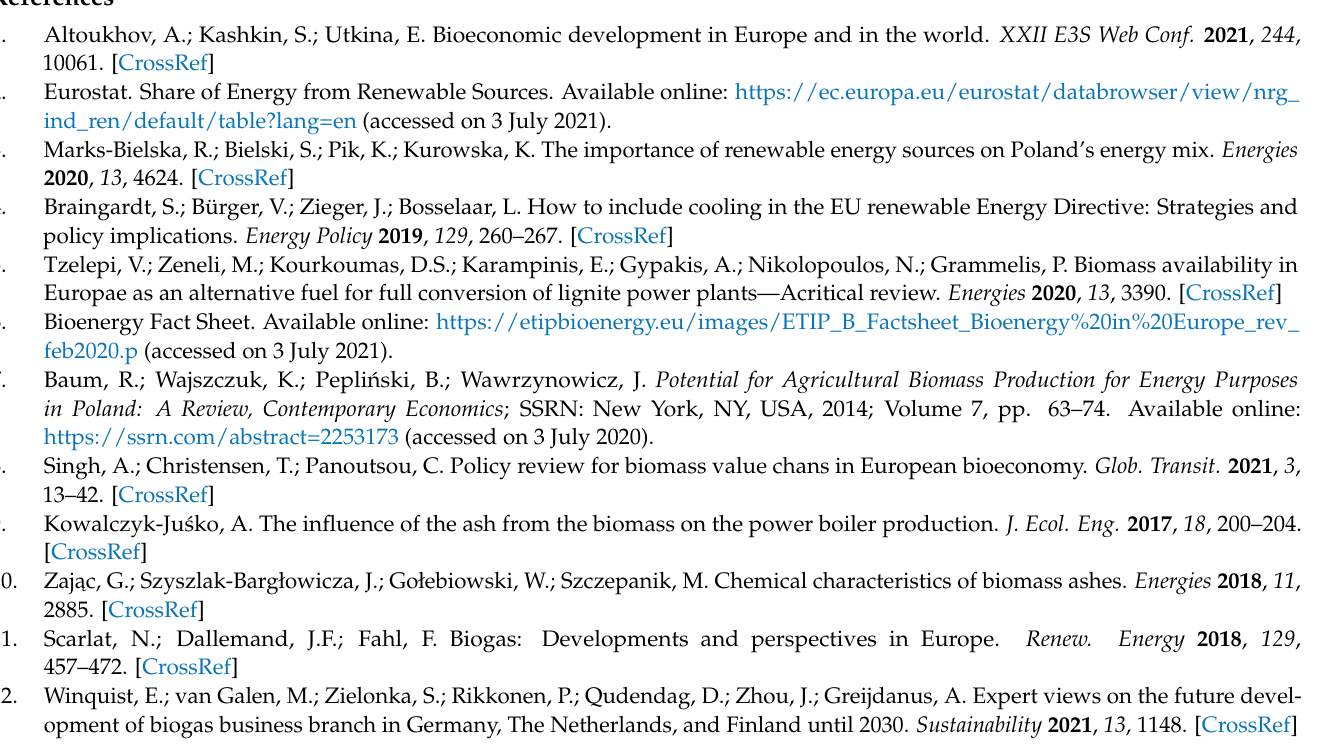
Table S4. The results of ANOVA analysis: content of nutrients, lead and cadmium ( F ratios); Table S5. Effect of the year on nutrients, lead and cadmium content in tomato fruits; Table S6. Matrix of Pearson’s correlation coefficients between tomato yield, yield components and quality parameters (n = 11); Table S7. Matrix of Pearson’s correlation coefficients between commercial yield of tomato (CY) and content of elements in fruits (n =